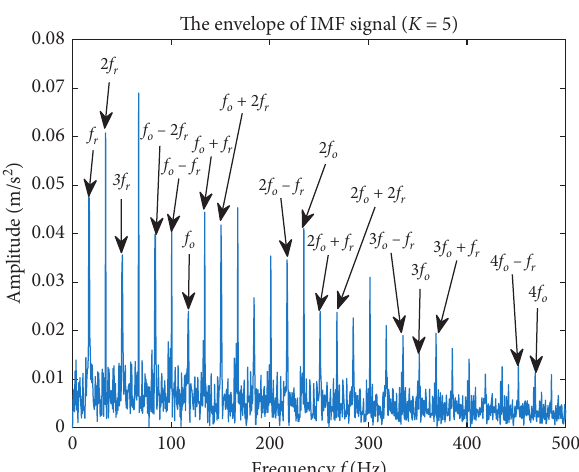
Figure 11: IMF signal envelope spectrum of outer ring with the VMD by TAGA optimization.